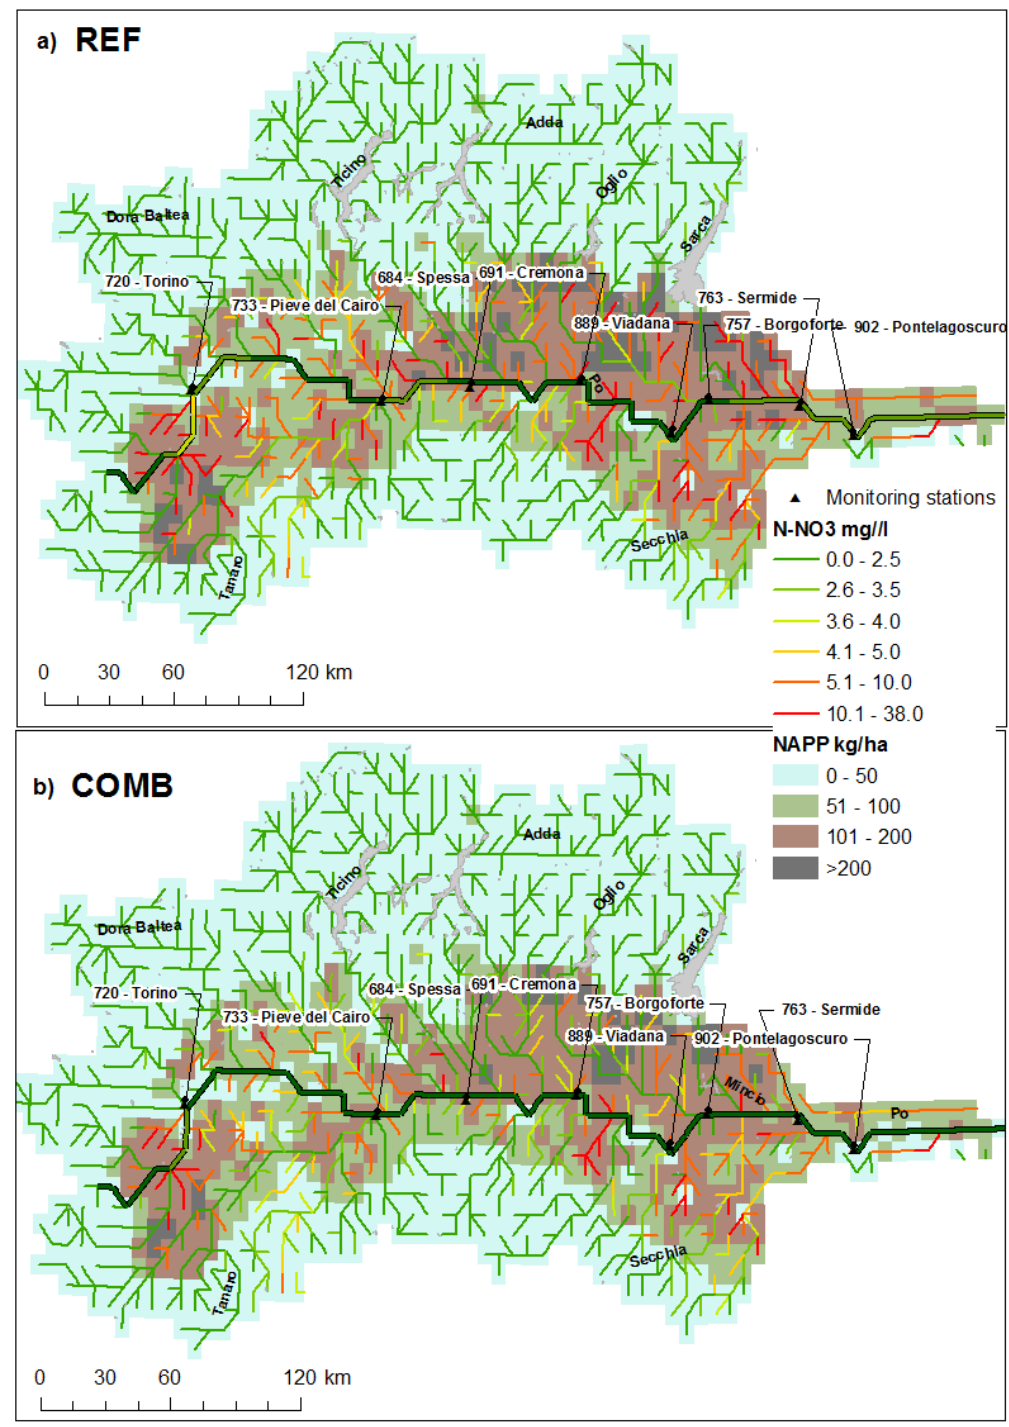
Figure A2. Spatial distribution of total nitrogen applied (kg/ha) and long term average of annual N-NO 3 concentrations (mg/L) in the period 2000–2012 for baseline REF ( a ) and scenario COMB ( b ).